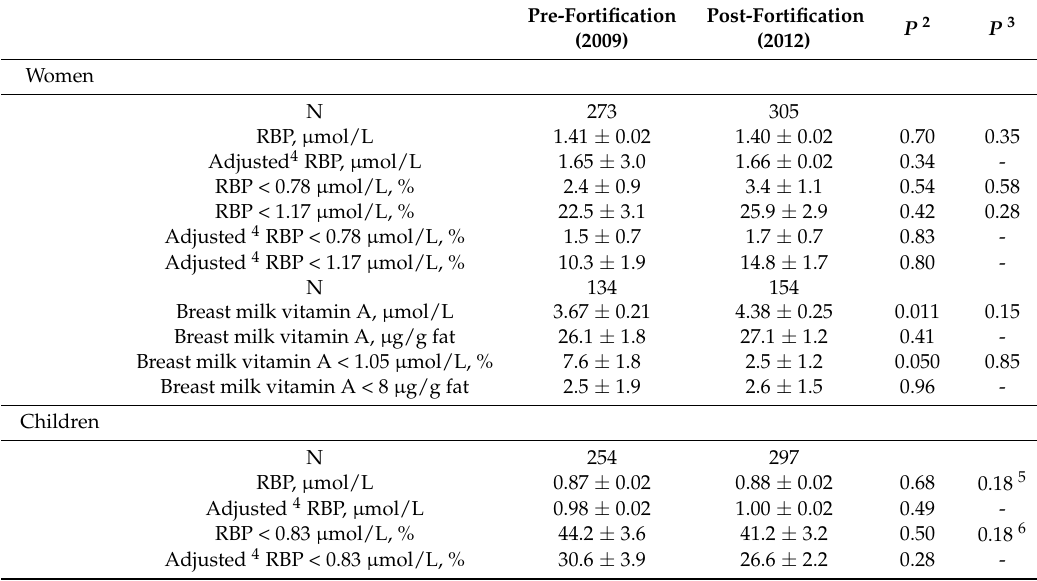
Table 4. Indicators of vitamin A status among women and children who participated in the baseline and post-fortification studies, and change from 2009 to 2012 1